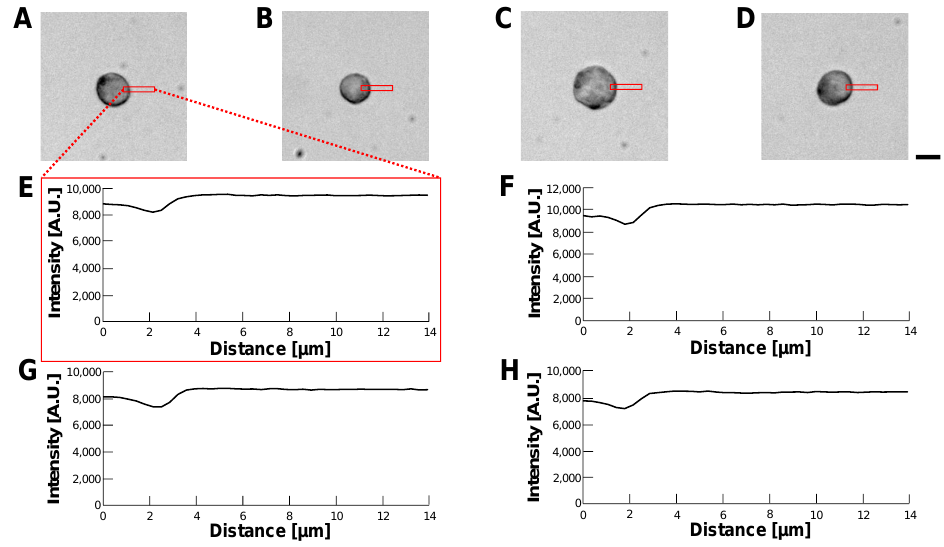
Figure 14. Comparision of permeability of HeLa cell-encapsulated alginate microcapsules in various buffer conditions by bright-field observation. ( A – D ): Bright-field images of HeLa cell- encapsulated alginate microcapsules. ( A ): 5% glucose solution ( B ): 10% glucose solution ( C ): 15% glucose solution ( D ): 1% alginate ester. ( E – H ): Intensity profiles of HeLa cell-encapsulated alginate microcapsules images ( A – D ), respectively. Bar,